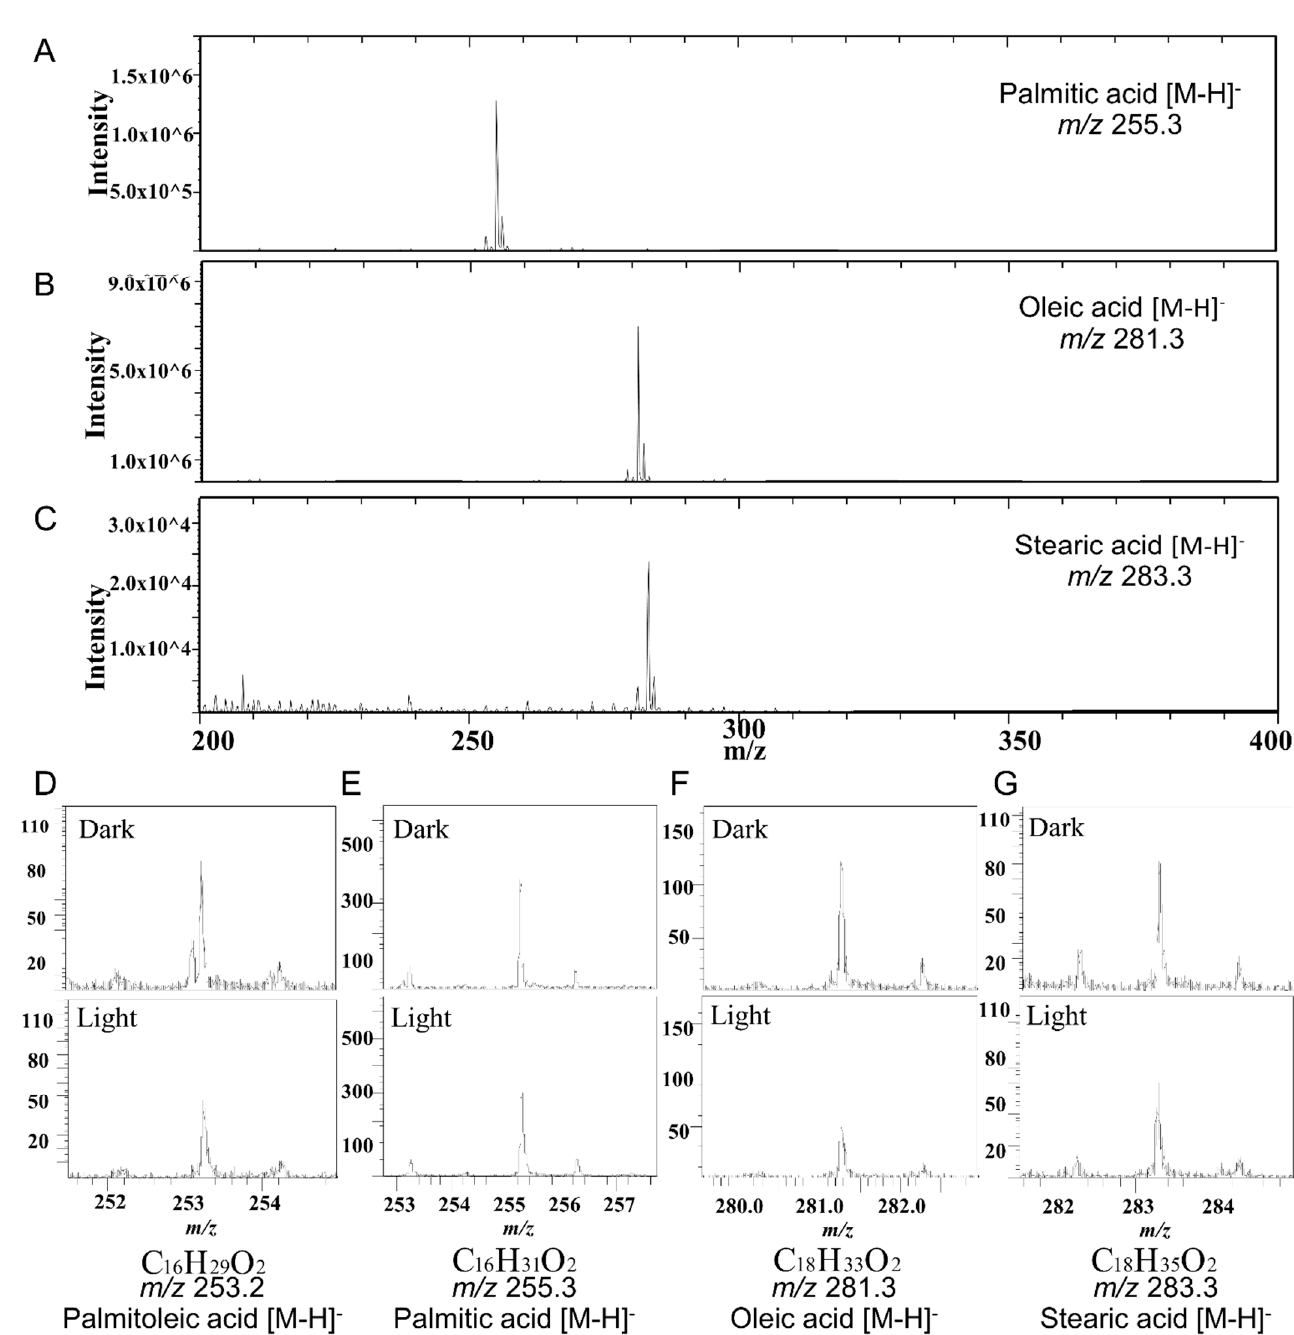
Black arrows: corresponding images and frames. Red lines: Paired images for Pearson’s R value calculation. ( C ) The co-localization analysis using the Image J Coloc2 plugin showed the reversibil- ity and reusability of the ER translocation. The Pearson’s R value representing the interaction be- tween iLID and SspB, using images of two channels as a group (Image connected by red lines in B ) Scale bars: 25 μ m.